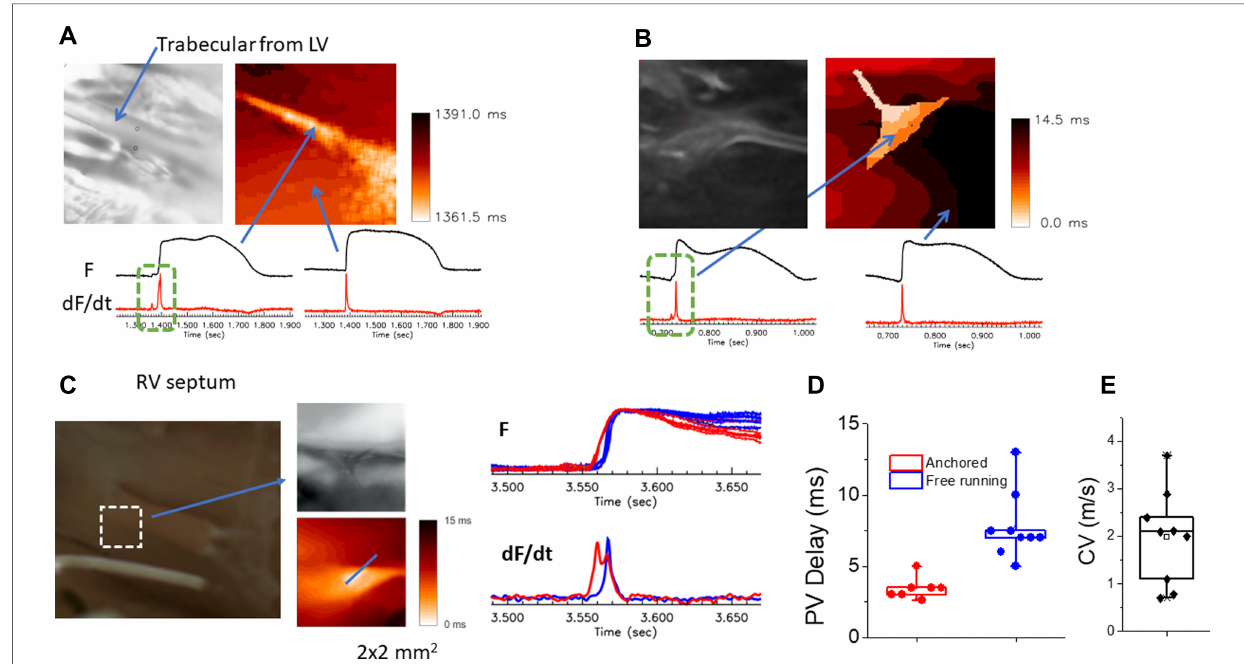
FIGURE 4 Detection of conduction delay through PVJs. ( A ) Two distinct upstrokes on optical mapping traces in Purkinje/endocardial region. The image on the left shows the location of mapping and trabecular muscle in the center. The optical mapping trace in one side of the trabecular muscle showed two distinct upstrokes (dotted green box), an initial small upstroke followed by a large upstroke (right panel, Supplementary Movie S4 ). The rest of regions in the fi eld of view did not show two distinct upstrokes (the right trace). ( B ) Sample traces recorded over a free-running Purkinje fi ber that is anchored to the trabecular muscles. Two distinct upstrokes are visible over the free-running Purkinje fi ber (the left trace). The superimposed activation map shows early excitation representing the free-running Purkinje fi ber (right panel, Supplementary Movie S5 ). ( C ) AP propagation toward papillary muscle (PM) of the right ventricle septum. High resolution mapping shows that free running Purkinje fi bers anchor and activate at the base of the PM. The sample traces showed two distinct peaks; the free-running Purkinje bundle (red) compared to the rest of PM and endocardium (blue), indicating that the PM AP is triggered early by the Purkinje network (bottom right panel, Supplementary Movie S6 ). ( D ) Summary of conduction delay across PVJs. Purkinje- ventricular delay measured from the time delay between the two upstrokes varied from 2 to 13 ms ( n =8 hearts, n =16 locations), most likely due to variability of Purkinje fi ber insulation from the ventricular myocardium. ( E ) CV along the Purkinje fi ber. Purkinje fi ber CVs (1.97±0.99 m/s) were measured from n =9 locations selected for their linear propagation for at least 1-mm, without